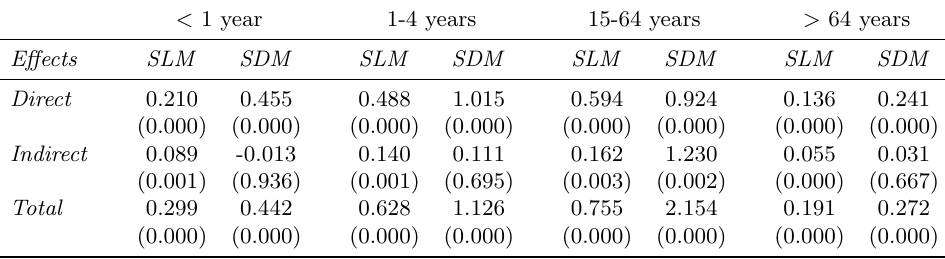
Table 5: Effects of PM 2 . 5 on ER visits due to respiratory diseases for age-groups < 1 year 1-4 years 15-64